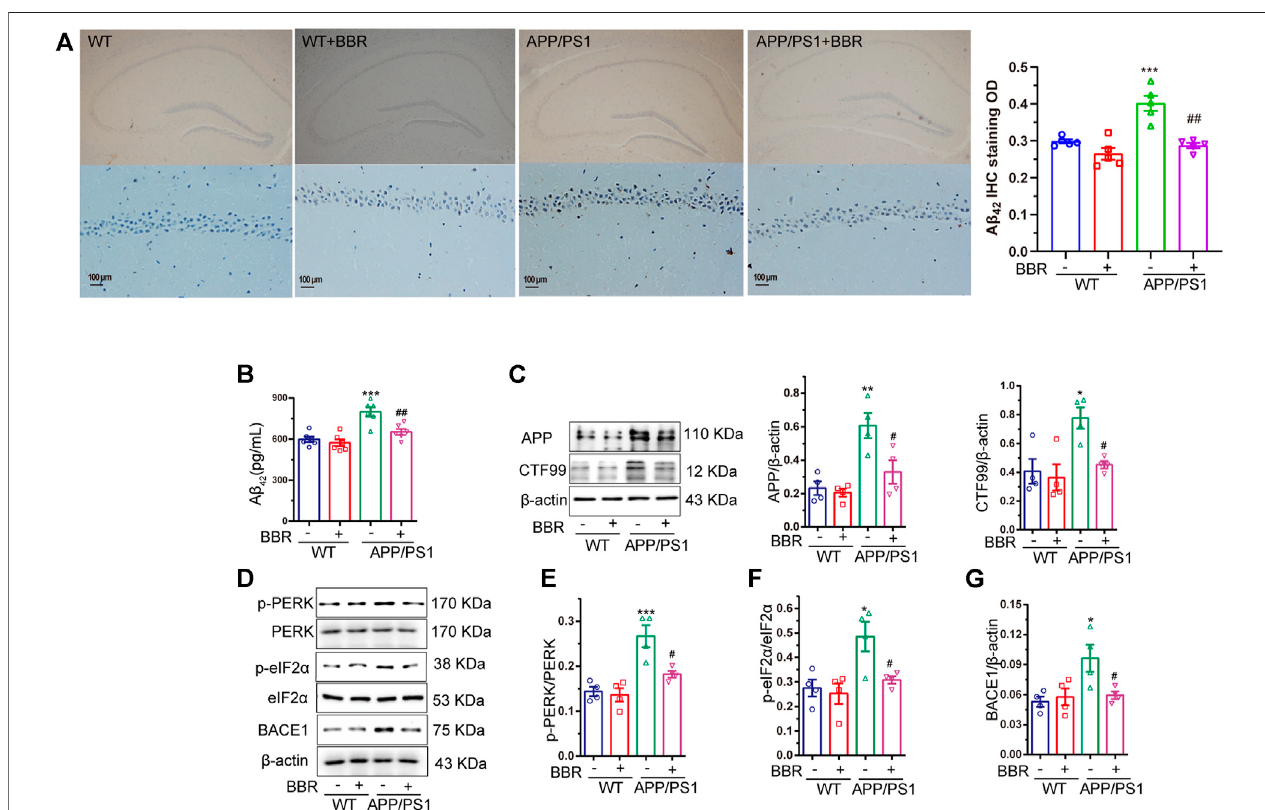
FIGURE 3 | Berberine reduces A β 42 production and deposition in APP/PS1 mice. (A) Representative IHC staining images and quanti fi cation of A β 42 in the CA1 region of the hippocampal tissue of mice. Scale bar is 100 μ m. (B) The contents of A β 42 in the supernatant of hippocampal tissue homogenate of APP/PS1 mice were detected by ELISA. (C) Western blot detection of APP and CTF99 expression in the hippocampal tissues of the mice, and quantitative analysis. (D – G) Western blot detectionofp-PERK,PERK,p-eIF2 α ,eIF2 α ,andBACE1inthehippocampal tissuesofmice,andquantitative analysisofp-PERK,p-eIF2 α ,andBACE1.Datawere presented as means ± SEM. * p < 0.05, ** p < 0.01, *** p < 0.001 vs. WT; # p < 0.05, ## p < 0.001 vs. APP/PS1 without